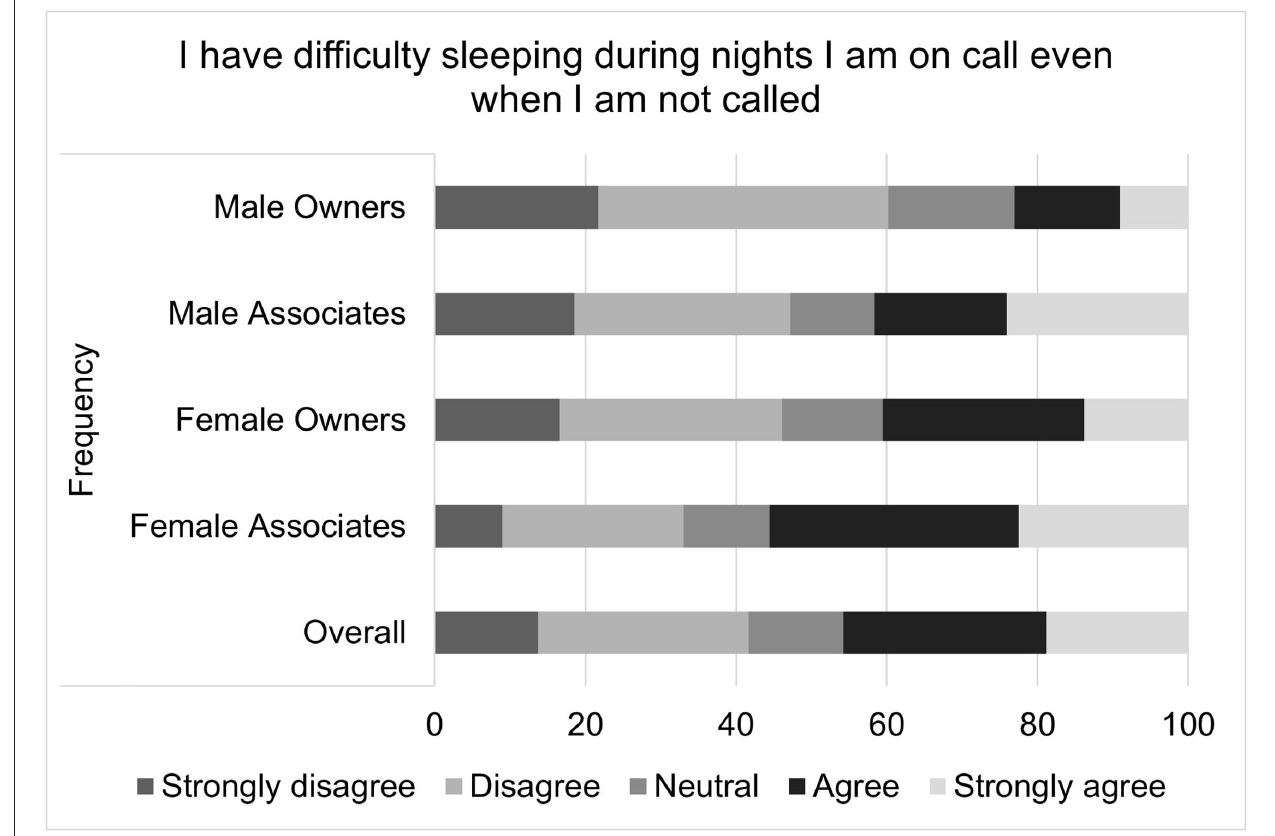
FIGURE 8 | Perceived inability to relax while on-call, as reported by male and female practice owners and associate